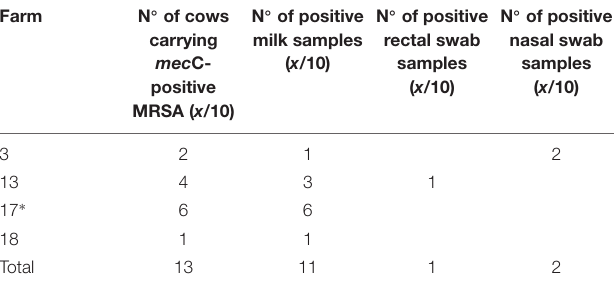
TABLE 1 | Description of the origin of the mec C-positive MRSA strains recovered in this